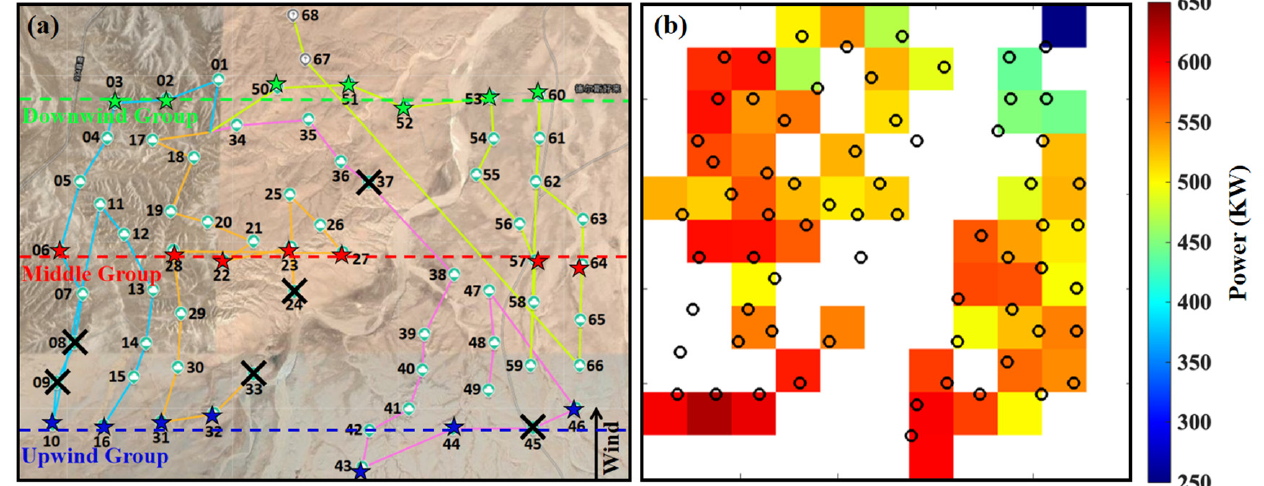
Figure 3. ( a ) The grouped wind turbines along southerly wind in the Gobi grassland wind farm, with upwind group turbines 10, 16, 31, 32, 42, 44, 46, middle group turbines 06, 22, 23, 27, 28, 57, 64, and downwind group turbines 02, 03, 50, 51, 52, 53, 60. ( b ) Distribution of the average generated powers in September 2021.